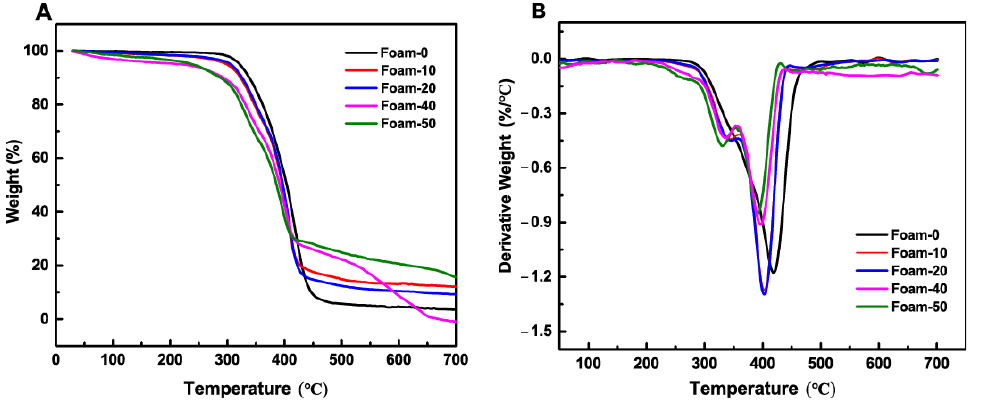
Figure 4. TG ( A ) and DTG ( B ) curves of composite foams.